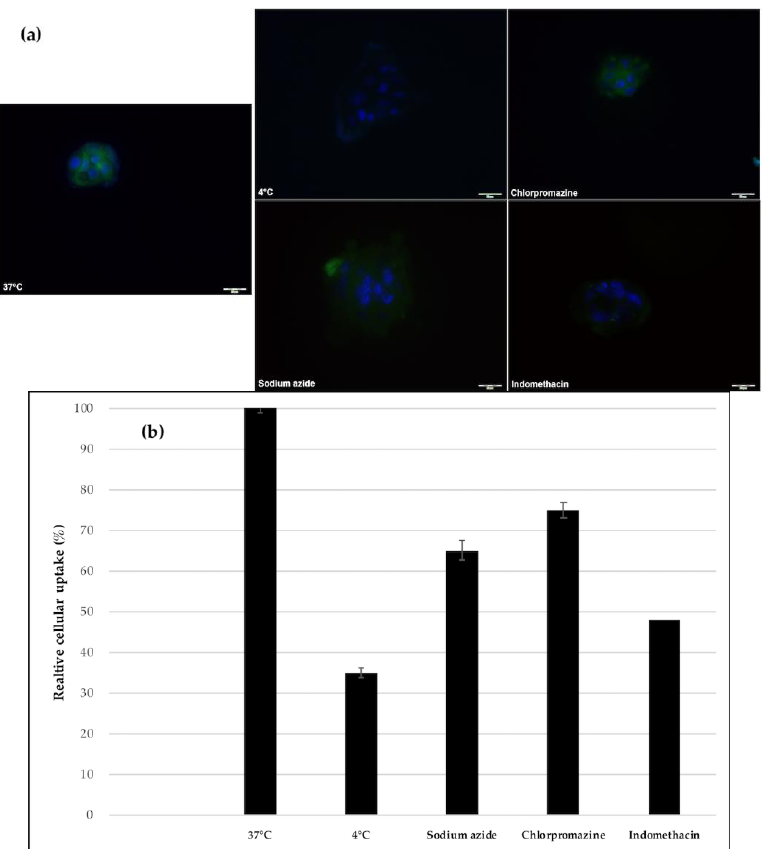
Figure 5. ( a ) Cellular uptake of FITC-NLCs (green staining), in the presence of endocytic inhibitors. Nuclei were stained with DAPI. Final magnification 400×; scale bar 20 µm. ( b ) Percentage of intracellular FITC in Caco-2 cells after 1 h of exposure to FITC-NLCs at 37 °C (100%) or in the presence of endocytic inhibitors. Results are expressed as means ± standard deviation, n = 3.